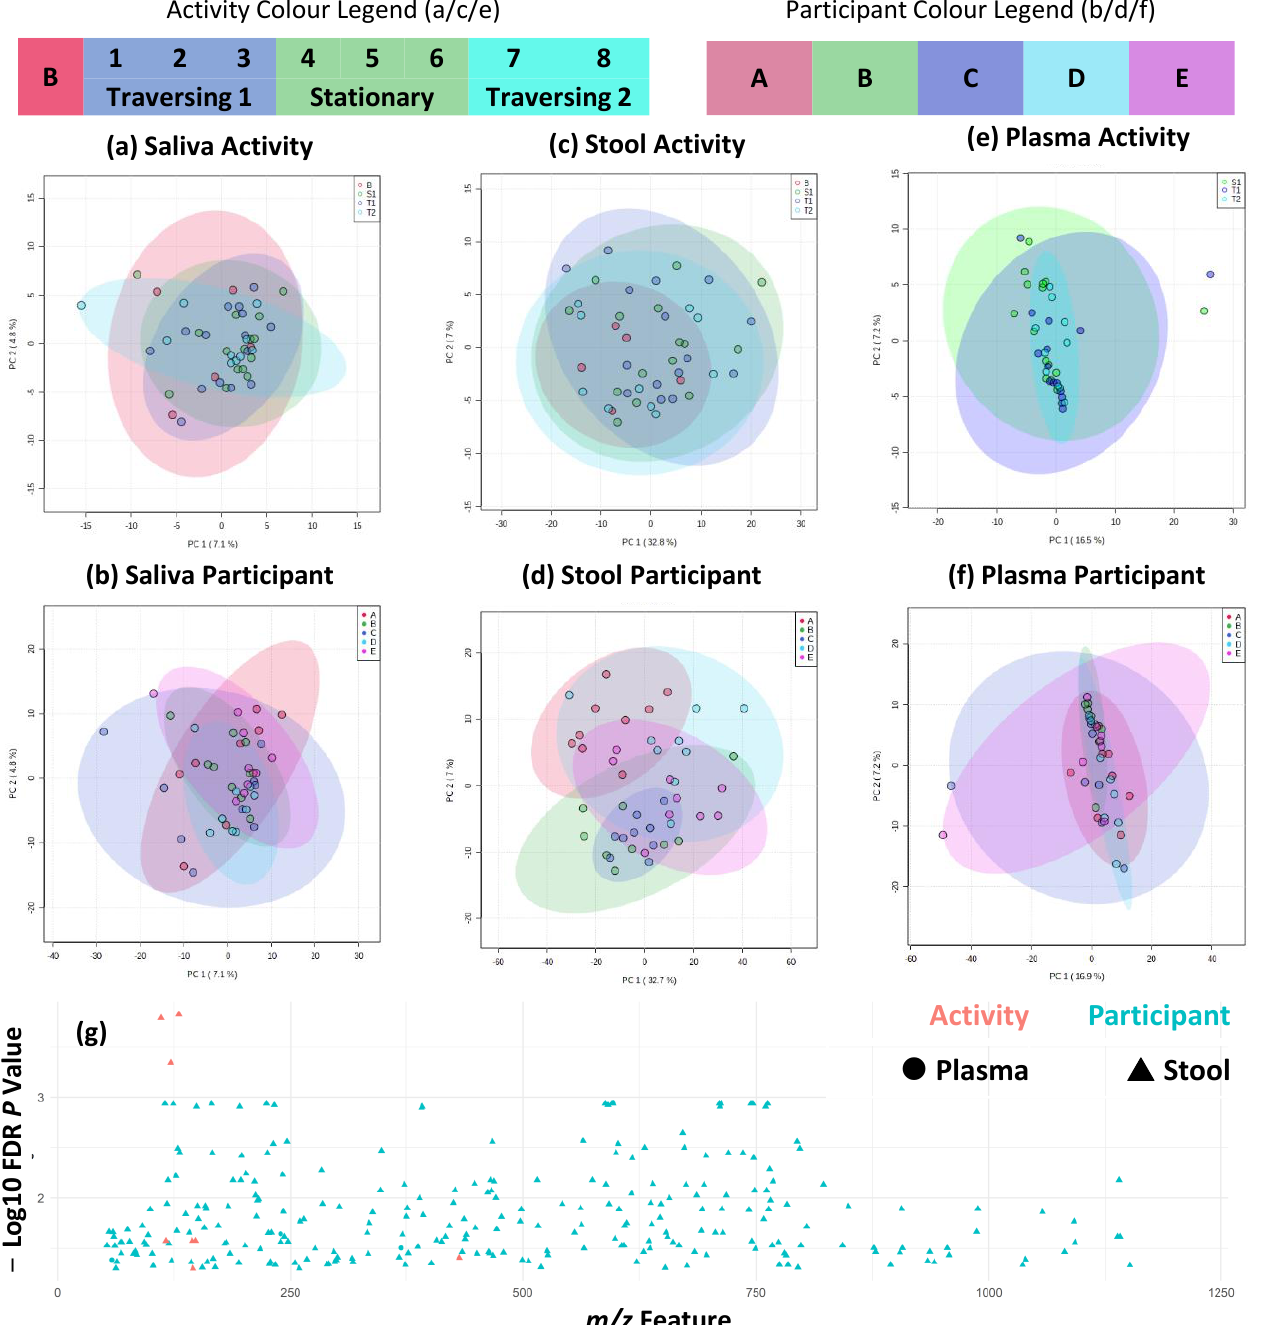
Figure 5. Metabolite fingerprinting shows maintenance of individual differences across traverse. ( a – f ) PCA plots of first two components across sample types and activity/participant differences, and ( g ) shows significantly different (FDR-corrected p < 0.05) metabolite fingerprint features across plasma and stool, as indicated by shape, and activity/participant differences, as indicated by colour shading and plotted from 50 to 1200 m/z range. No significantly different features were detected in saliva samples. Figure shows negative ion detection mode FIE-MS metabolite fingerprints. Equiva- lent figures for positive ion detection mode FIE-MS metabolite fingerprints are given in Supplemen- tary Figure S3.